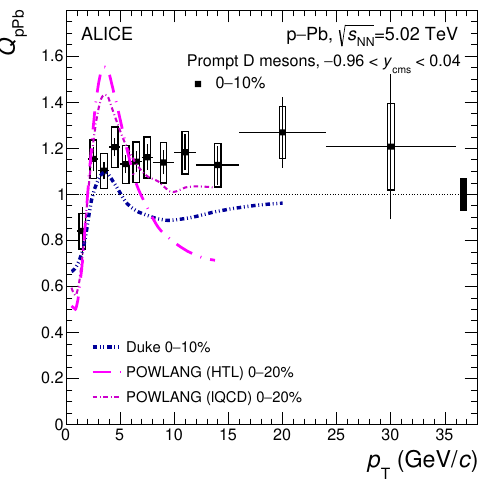
Figure 11 . D-meson Q pPb measured in the 0{10% centrality class compared with the predictions of the Duke [52] and POWLANG [53] transport models. The vertical bars and the empty boxes represent the statistical and systematic uncertainties. The colour-(cid:12)lled boxes at Q pPb = 1 represent the normalisation uncertainties.